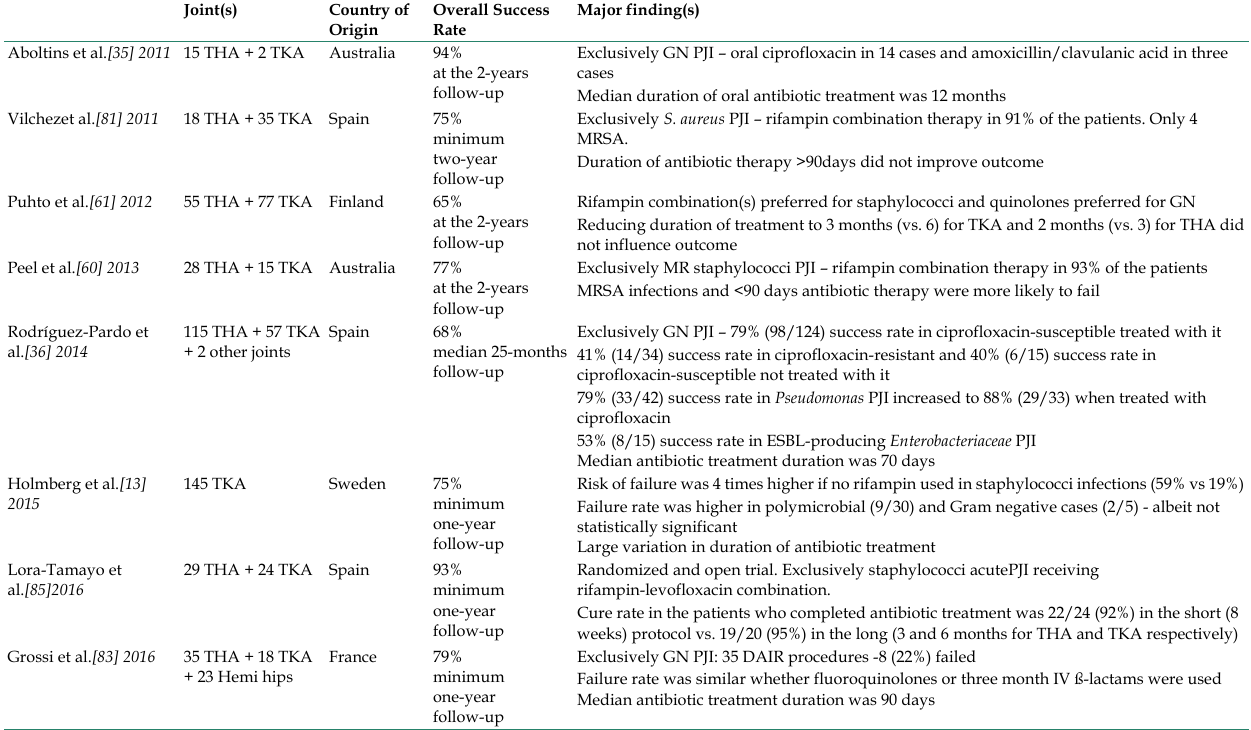
Table 2. Summary of selected recent findings regarding antibiotic regimen after DAIR